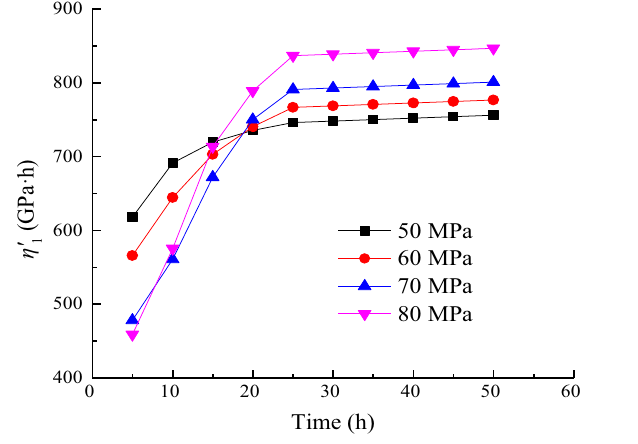
Figure 14. Duration of η 1 when σ 3 = 15 MPa.